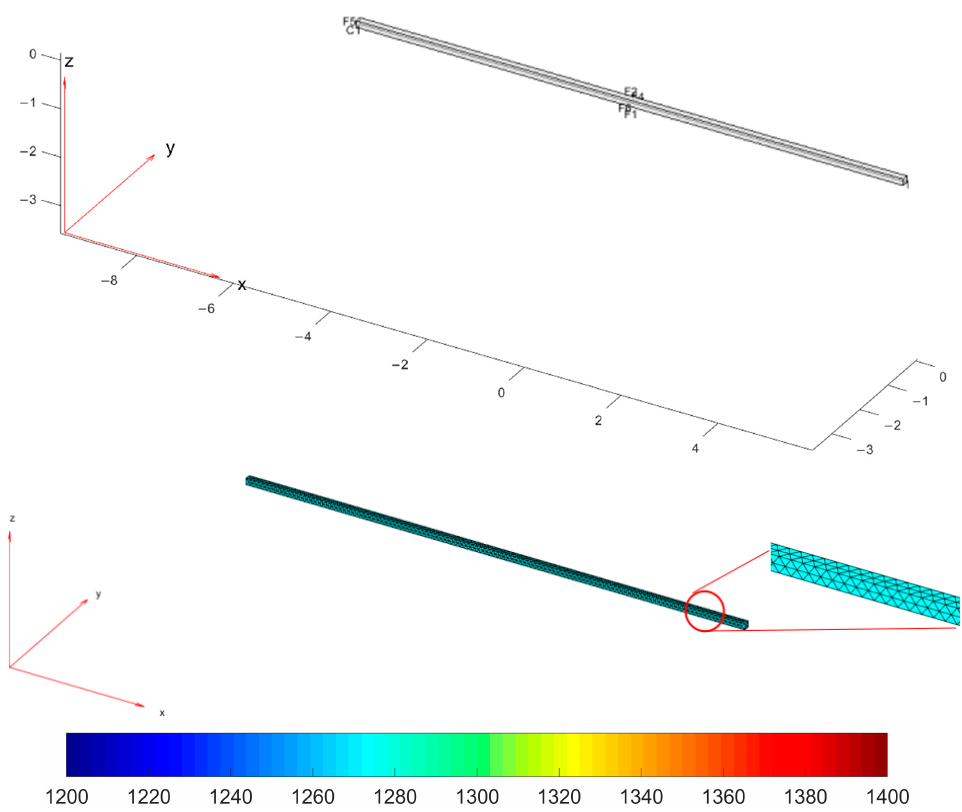
Figure 12. Modelization: 3D model of a billet, 3D model mesh, and color temperature scaling (K).